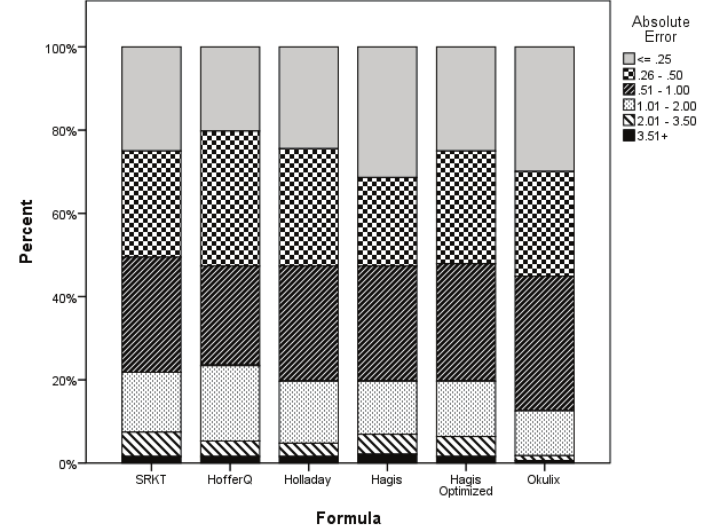
Figure 2. The absolute prediction error of the formulas based on the axial length. There were no statistically significant differences between the other formulas in subgroup analysis based on the axial length.